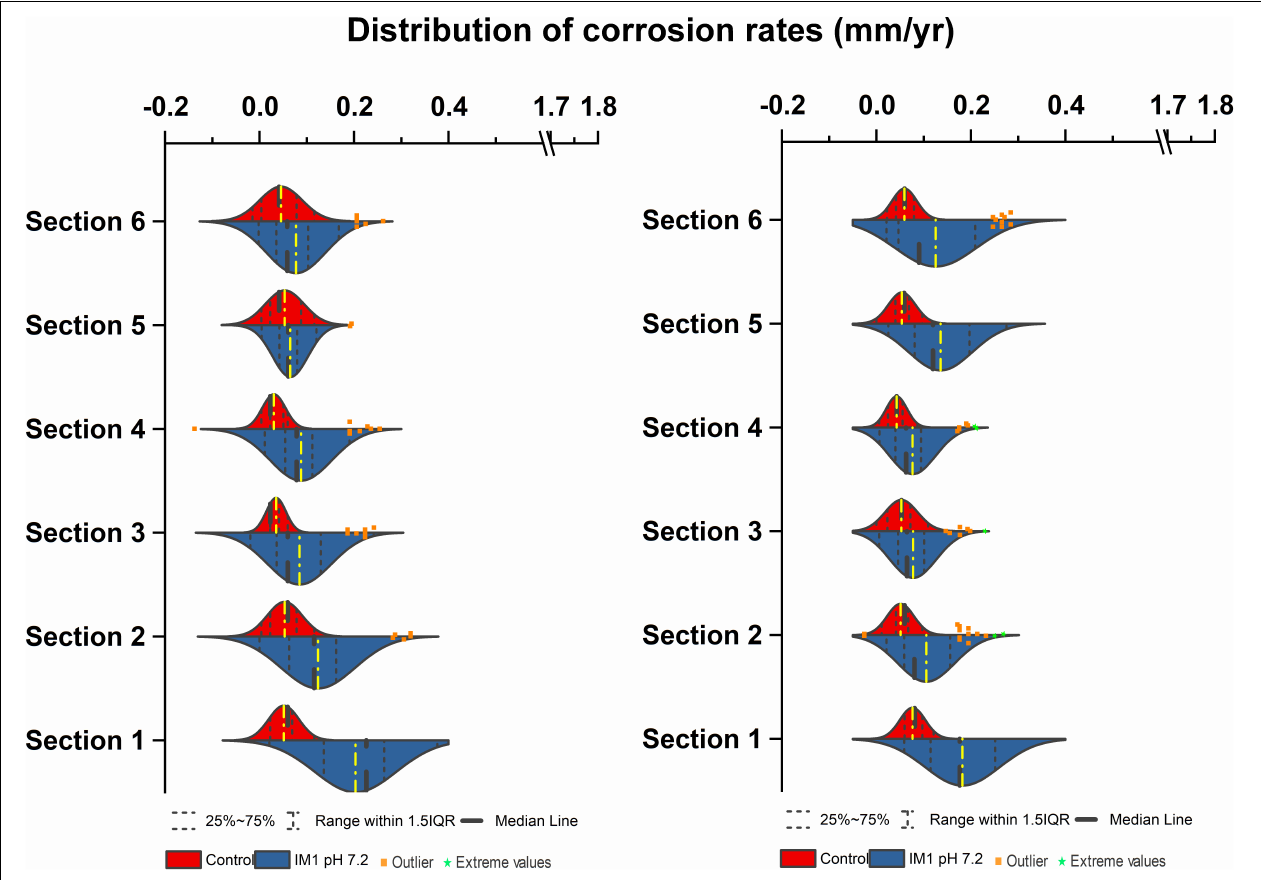
FIGURE 3 | Corrosion rates distribution (mm/yr) of Methanobacterium IM1 set 1 (left) and Methanobacterium IM1 set 2 (right) at pH 7.2 compared against abiotic control in flow-through system columns incubated for 3.5 days without flow. Columns were filled with glass bead as separation medium and operated for 14 days with flow. Corrosion rate distribution, median and outliers of three biological replicates are